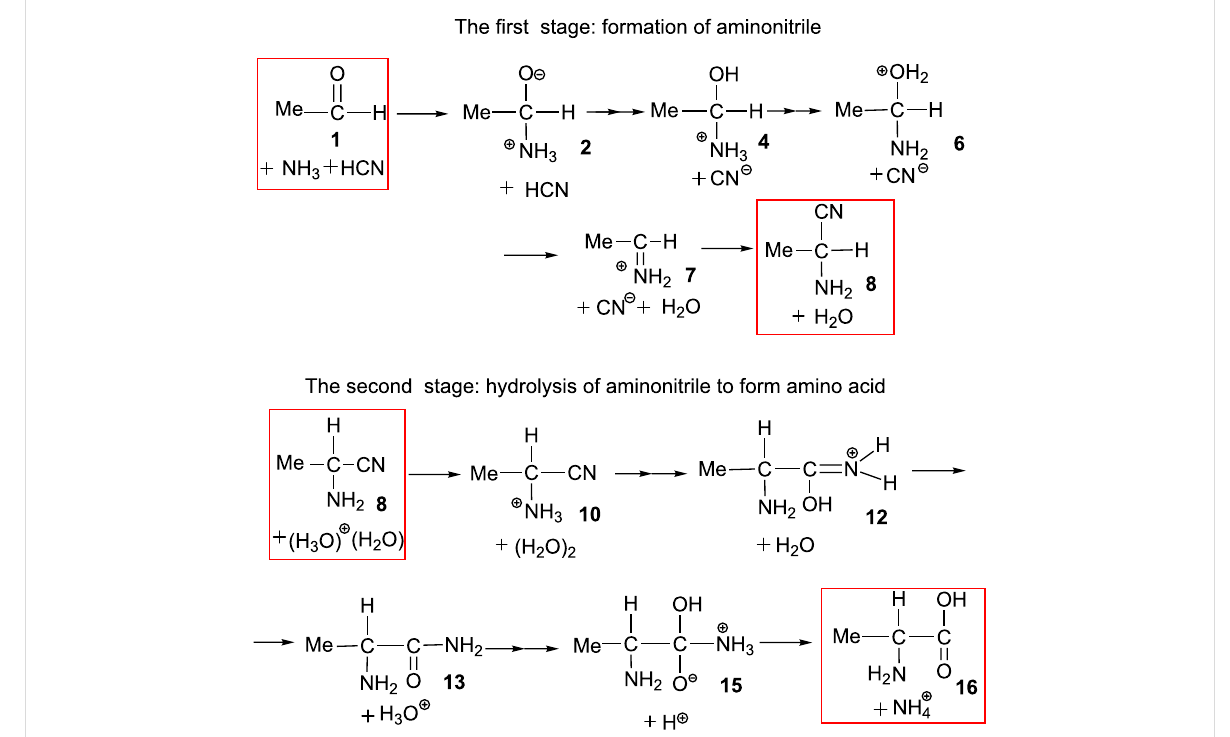
Scheme 9: Summary of the present computational work expressed by minimal